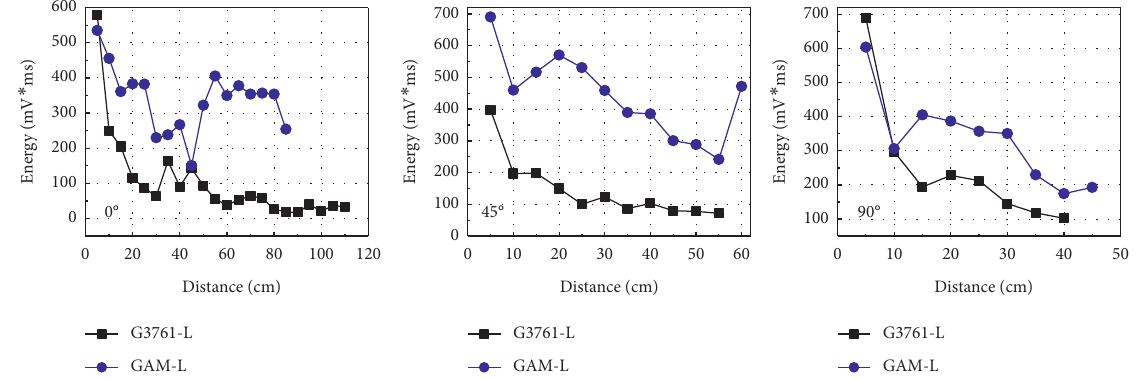
Figure 6: The attenuation curves of the AE Energy in different directions for G3761-L and GAM-L. Table 4: The measuring point positions of AE waveforms. Rock number (measuring point)